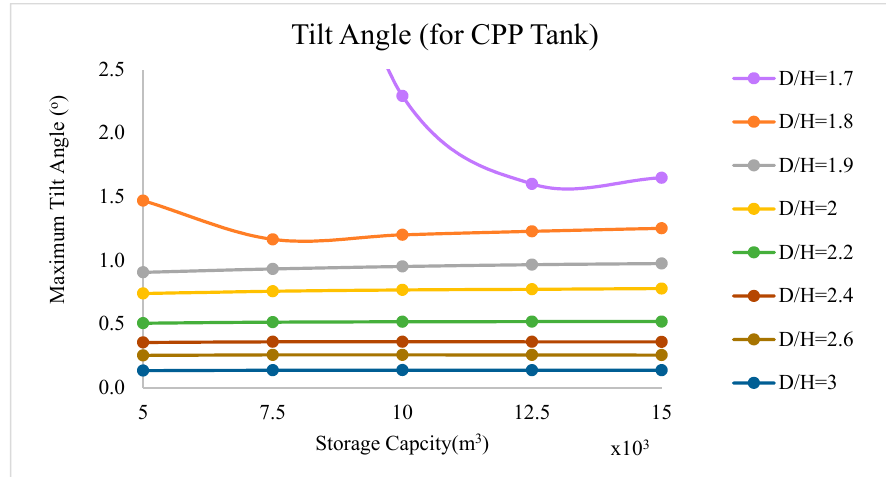
Figure 34. Maximum tilting angle of single hull cylindrical tank (5000–17,500 m 3 ).